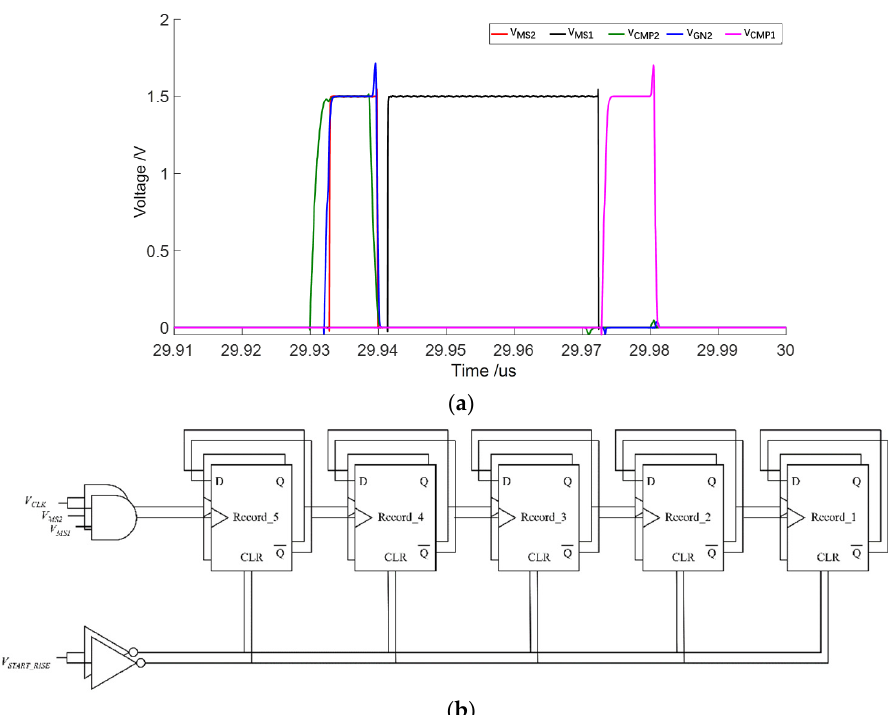
Figure 8. ( a ) The waveforms of the auxiliary signals and ( b ) the schematic diagram of the recording sequence circuit.